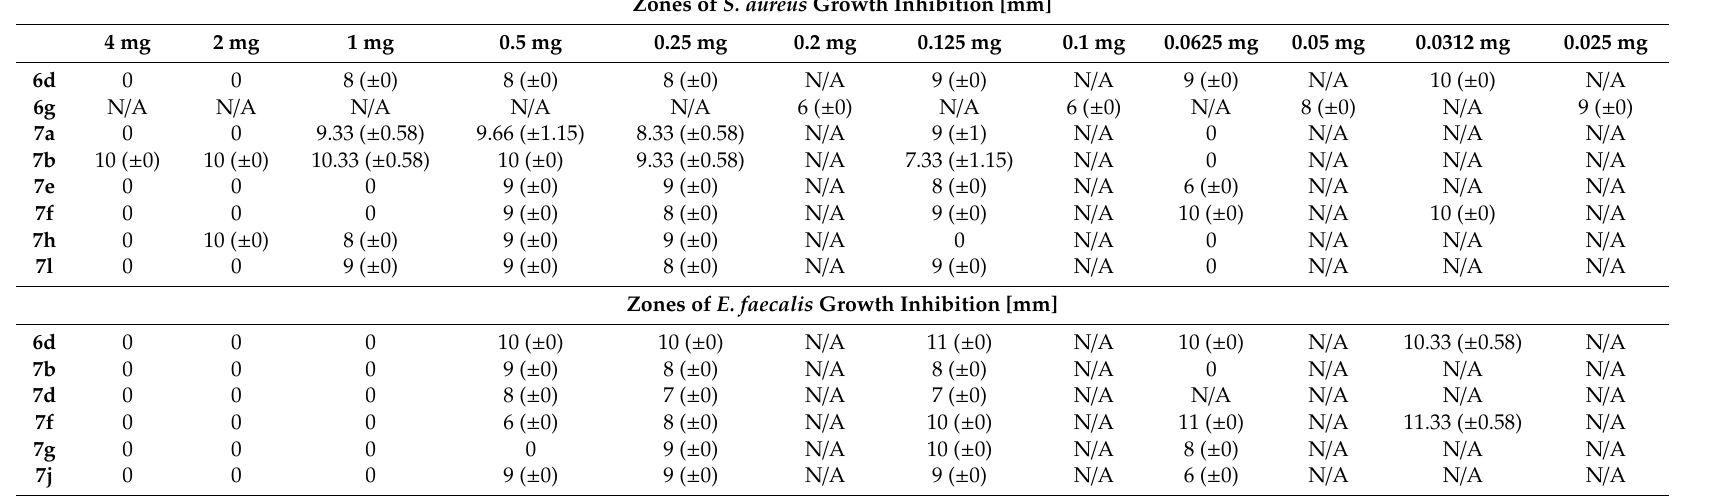
Table 4. Mean diameter of inhibition zones obtained by loaded discs with various compounds’ quantities of tested 1,2-benzothiazine derivatives. Values in brackets are standard errors of